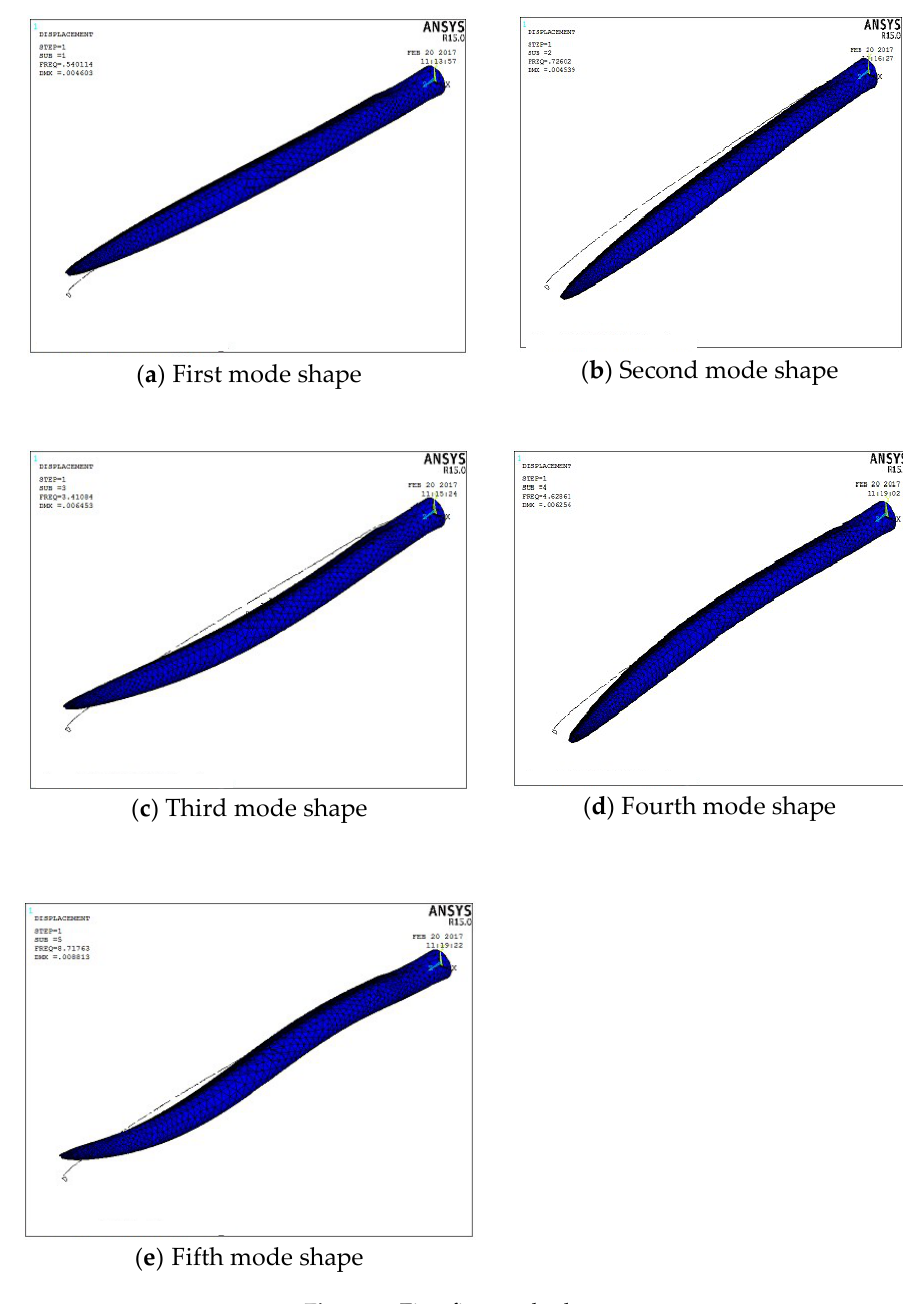
Figure 7 . First five mode shapes. Figure 7. First five mode shapes. Table 2. First five mode frequencies and their mode shape Table 2. First five mode frequencies and their mode shape features.